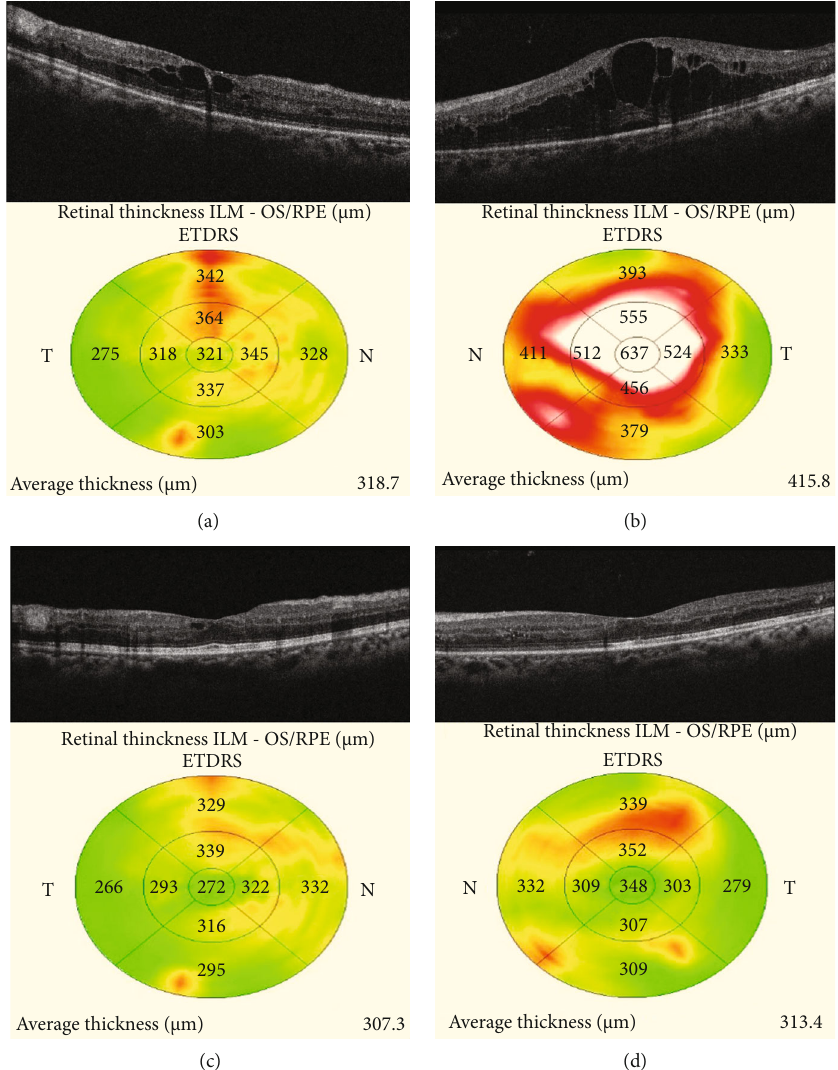
Figure 2: Spectral-domain optical coherence tomography scans of both the eyes (OU) showing the presence of cystoid macular edema (CME) at baseline (a, b). One month after intravitreal brolucizumab therapy, the patient demonstrated a bilateral reduction in the CME (c,